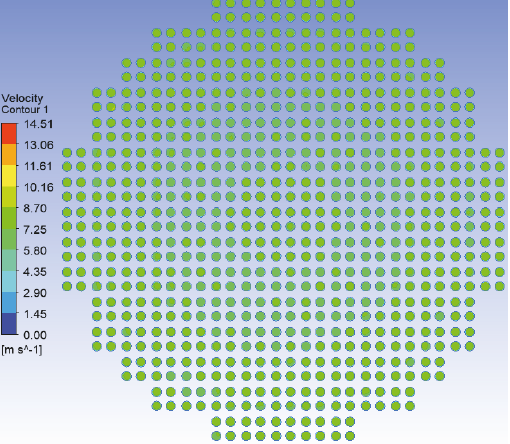
Figure 10: Velocity distribution at outlet of the lower core support